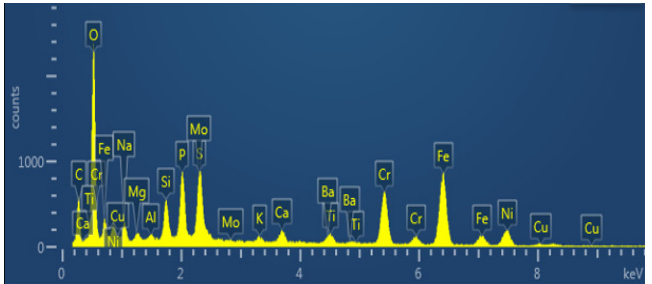
Figure 8. Morphology of Corrosion Pits in Super 13Cr Tubing. ( a ) Morphology of Corrosion Pits When the Pitting Shape Parameter Is 0.243. ( b ) Morphology of Corrosion Pits When the Pitting Shape Parameter Is 0.296.